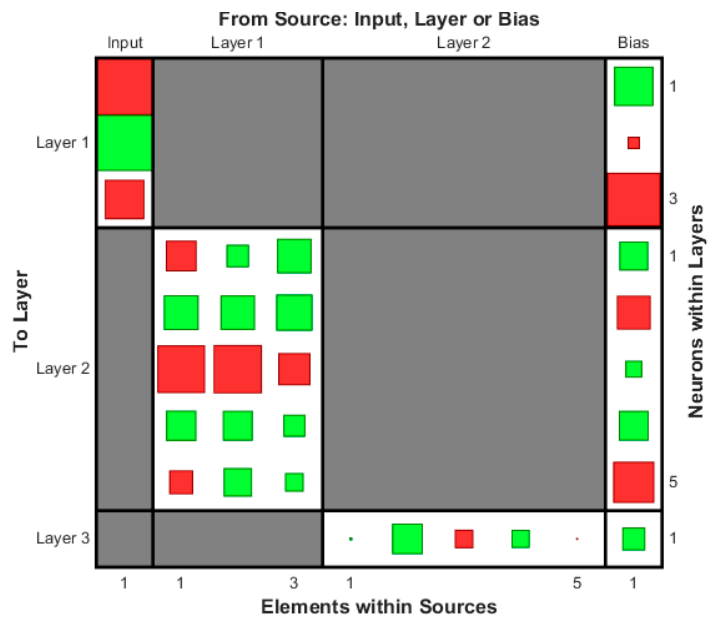
Figure 13. Final weights and bias values of the optimum BPNN model 1-3-5-1 (the values are presented in Table 3). Table 3. Final weights and bias values of the optimum BPNN model 1-3-5-1.